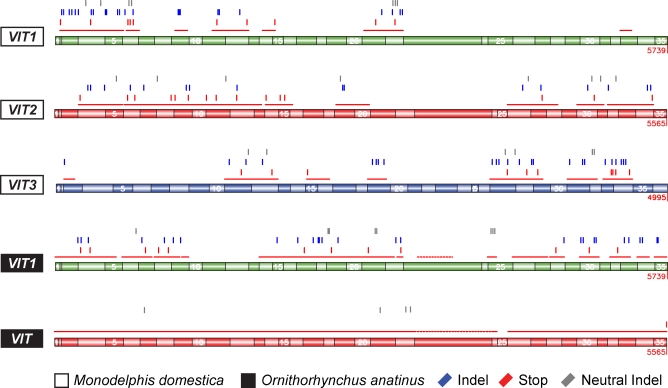
Overview of Intact and Disabled VIT Genes from Opossum and PlatypusThin red lines indicate VIT sequences that could be retrieved. The sequences are aligned to the known 35 (VIT1/VIT2) and predicted 36 (VIT3) coding exons from the chicken VIT genes. Indels (blue), stop codons (red), and neutral indels (gray) are shown (the cumulative indel count is provided in Table 1). We note that the platypus VIT gene was aligned to the chicken VIT2 gene to illustrate the absence of sequence disablements (the platypus VIT sequence could not be unambiguously identified as VIT2 or VIT3, see text for details).